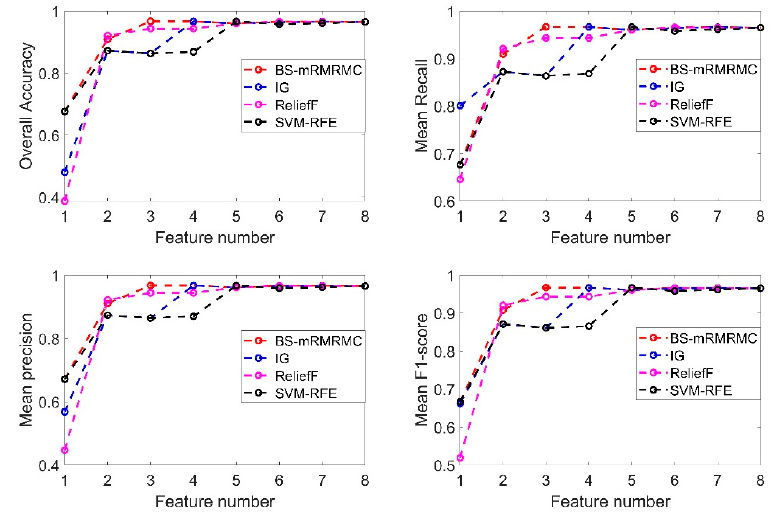
Figure 13. Comparison diagram of average indexes of each category identified by four methods under different feature quantities.